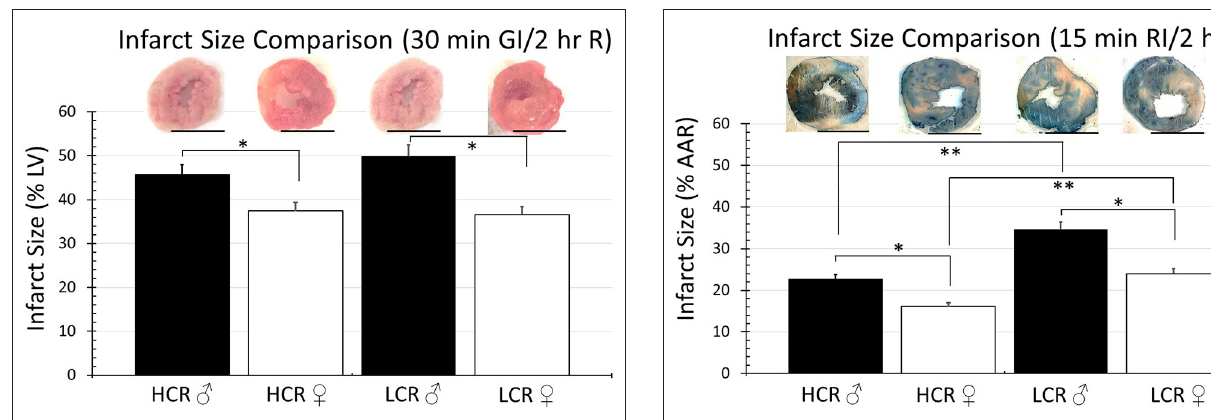
FIGURE 3 | Comparison of the average infarction size normalized to the whole heart between HCR male/female and LCR male/female rats after 30min ischemia and 2h reperfusion using an ex vivo buffer-perfused global ischemia (GI) model. Scale bars in images indicate 5mm. Significant differences were noted between sexes within each phenotype, but not between phenotypes for either sex (* p < 0.05 for the comparison indicated).